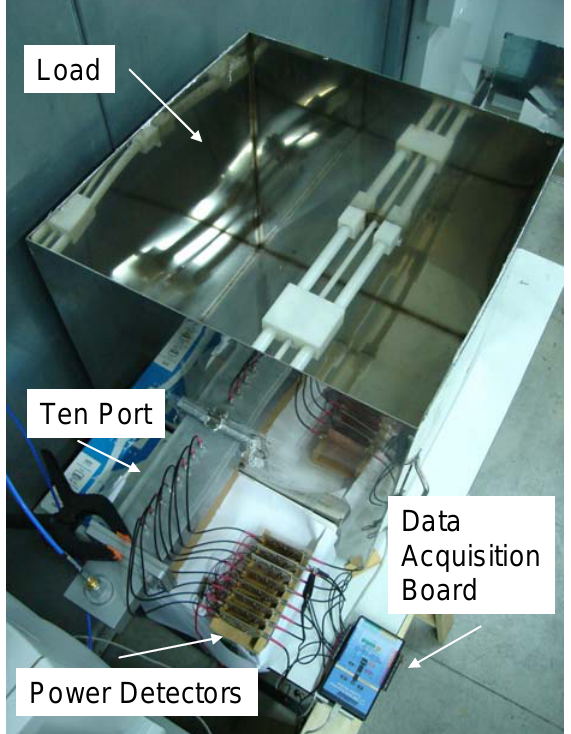
Figure 11. Experimental set up for both sensor calibration and validation.